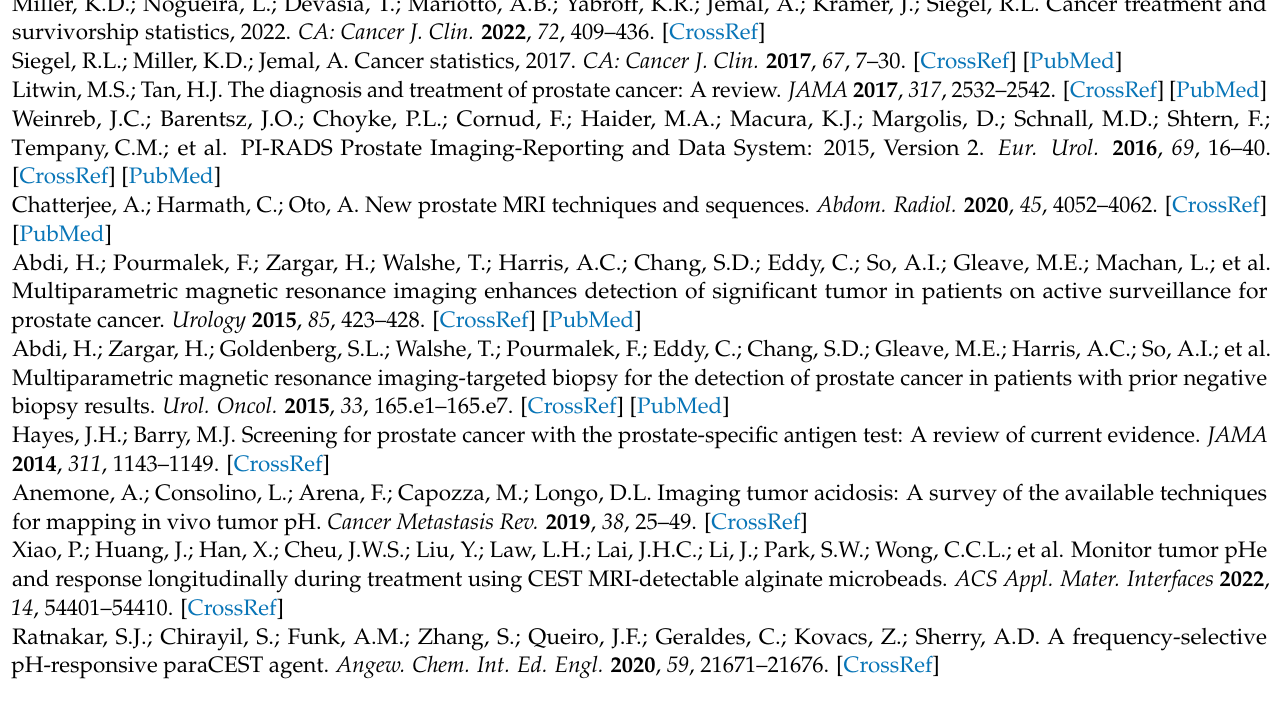
medium pH; Figure S2: RT-PCR and WB expression of NHE1 and V-APTase in DU145 and PC3 prostate cancer cells; Figure S3: Tumor volume upon chronic Esomeprazole treatment for the DU145 prostate orthotopic murine